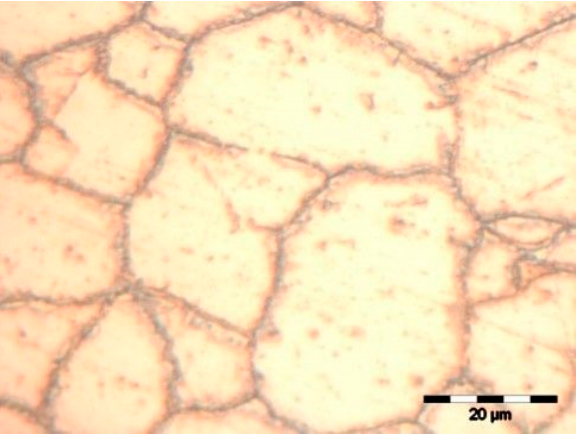
Figure 5. Optical micrography for 310H oxidized in supercritical static water for 2160 h at ×1000 magnification.